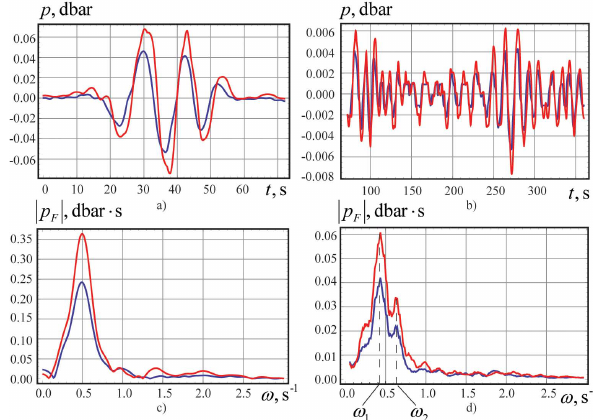
Fig. 4. Records of pressure gauges 3 (a, b) , 1 (c) (blue curve), and 2 (d) (red curve). (b) shows in detail the perturbation indicated by a dashed line rectangle in (a) .